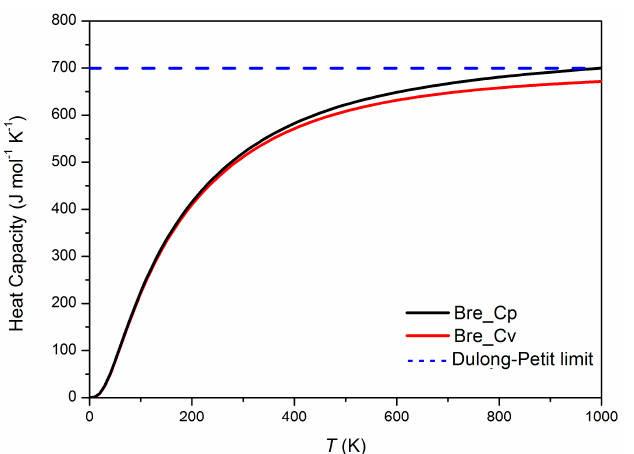
Figure 7. Isobaric and isochoric heat capacity ( C p and C v , respectively) of Ca 7 MgSi 4 O 16 -Bre. Note that the C v values remain lower than the harmonic limit of Dulong–Petit (3 R /M, with R as the gas constant and M as the molar mass) for T less than 1000 K, suggesting that either the quantum ef- fects for the ionic vibrations remain noticeable for this T range, or our C v values have been slightly underestimated (presumably by a few percent) because the volume used in the calculation is for zero P and zero T . 4. Conclusion Ca 7 MgSi 4 O 16 -Bre has been successfully synthesized at 1.2 GPa and 1373 K, and its structure has been determined by single-crystal X-ray diffraction data. We find that the Ca 7 MgSi 4 O 16 -Bre has the space group Pnnm . Although this space group may be reduced to the space group Pnn 2 as significant amounts of Ba and Mn enter the structure, it tol- erates low levels of chemical impurities such as Na, Ba, and P. Some first-principles calculations have been carried out as well. The results suggest that the isothermal bulk modulus of the Ca 7 MgSi 4 O 16 -Bre is 90.6(4) GPa (with a pressure derivative of 5.7(1)), the isobaric heat capacity is C p = 8.22(2) × 10 2 – 3.76(6) × 10 3 T − 0.5 – 1.384(4) × 10 7 T − 2 + 1.61(8) × 10 9 T − 3 J mol − 1 K − 1 (298–1000 K), and the standard vibrational entropy is 𝑆 (cid:2870)(cid:2877)(cid:2876) (cid:2868) = 534.1 (22) J mol − 1 K − 1 . Supplementary Materials: The followings are available online at www.mdpi.com/xxx/s1, Figure S1: Back scattered electron (BSE) image of bredigite, Table S1: atomic coordinates and U(eq) for